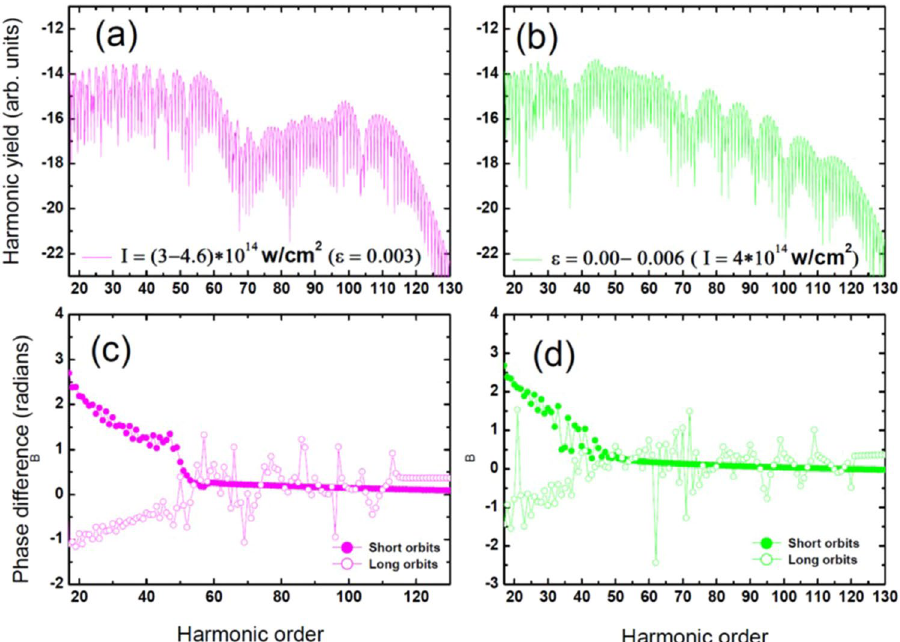
Figure 4. Near field phase matching High-order harmonic spectra in amplitude ( a and b ) (in logarithmic scale) for a neon atom exposed to a monochromatic field of frequency ω = 0.055 a.u. (wavelength of 825 nm). In panel (a) the intensity varies from I = 3.10 14 W/cm² to I = 4. 6 .10 14 W/cm² while ε = 0.003. In panel (b) the intensity is constant ( I = 4.10 14 W/cm²) while intensity range from ε = 0 to 0.006. For both above cases, the phase difference is calculated both for short (closed circles) and long orbits (open circles), panels (c and d). The yield of total HHG spectra is calculated as the coherent sum of all spectra computed at each inhomogeneity strength with steps of